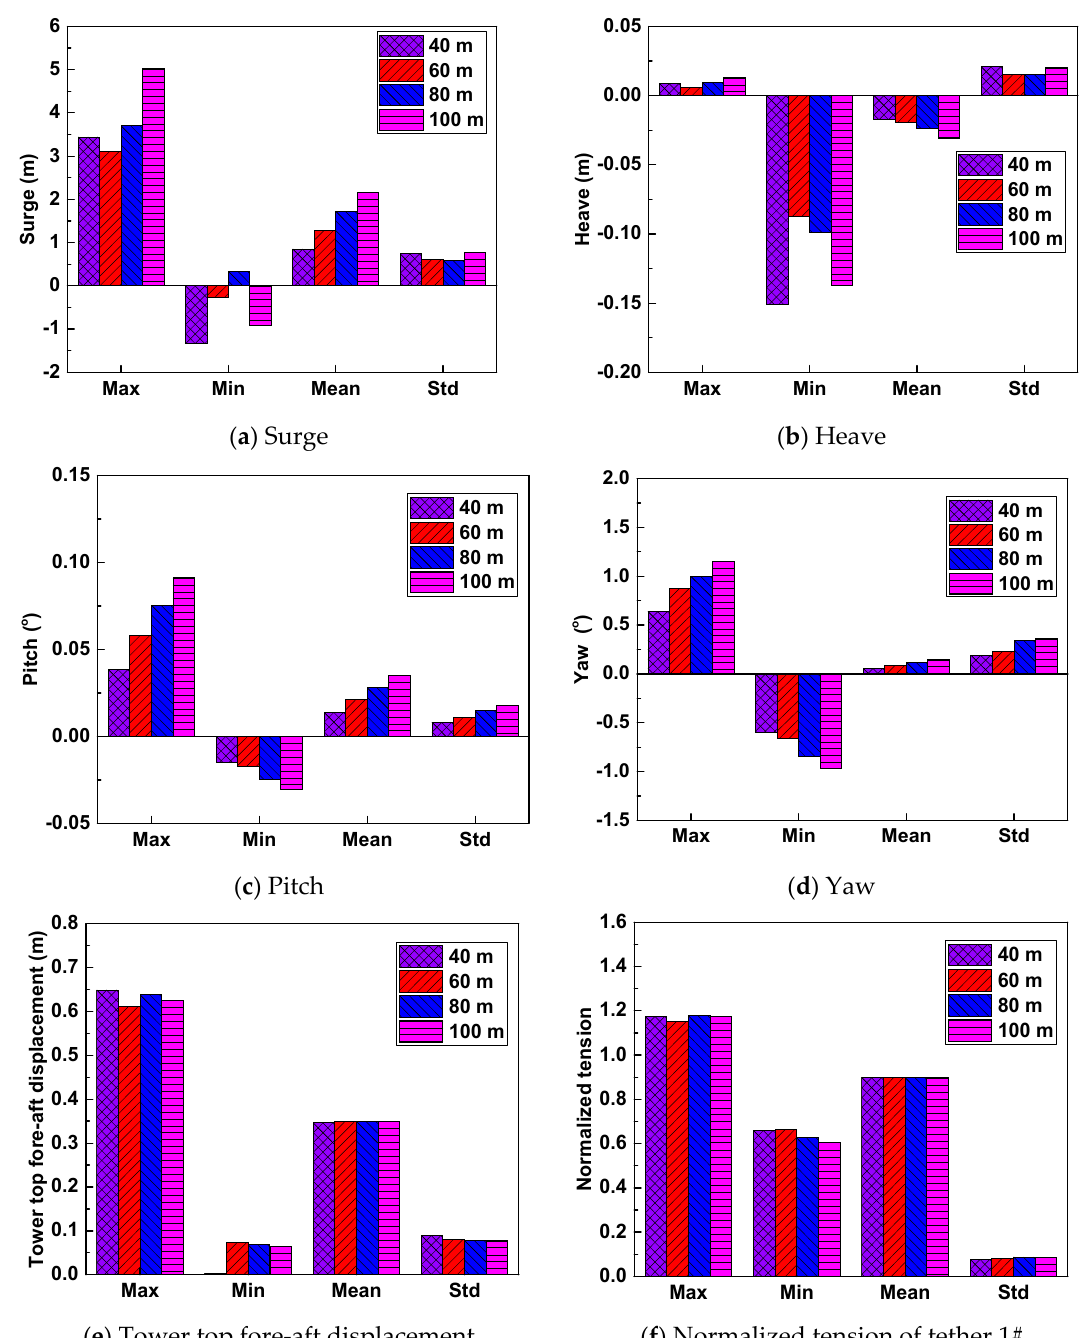
Figure 9. Comparison of platform motion, tower fore-aft displacements, tension of tether 1# for different tether lengths.